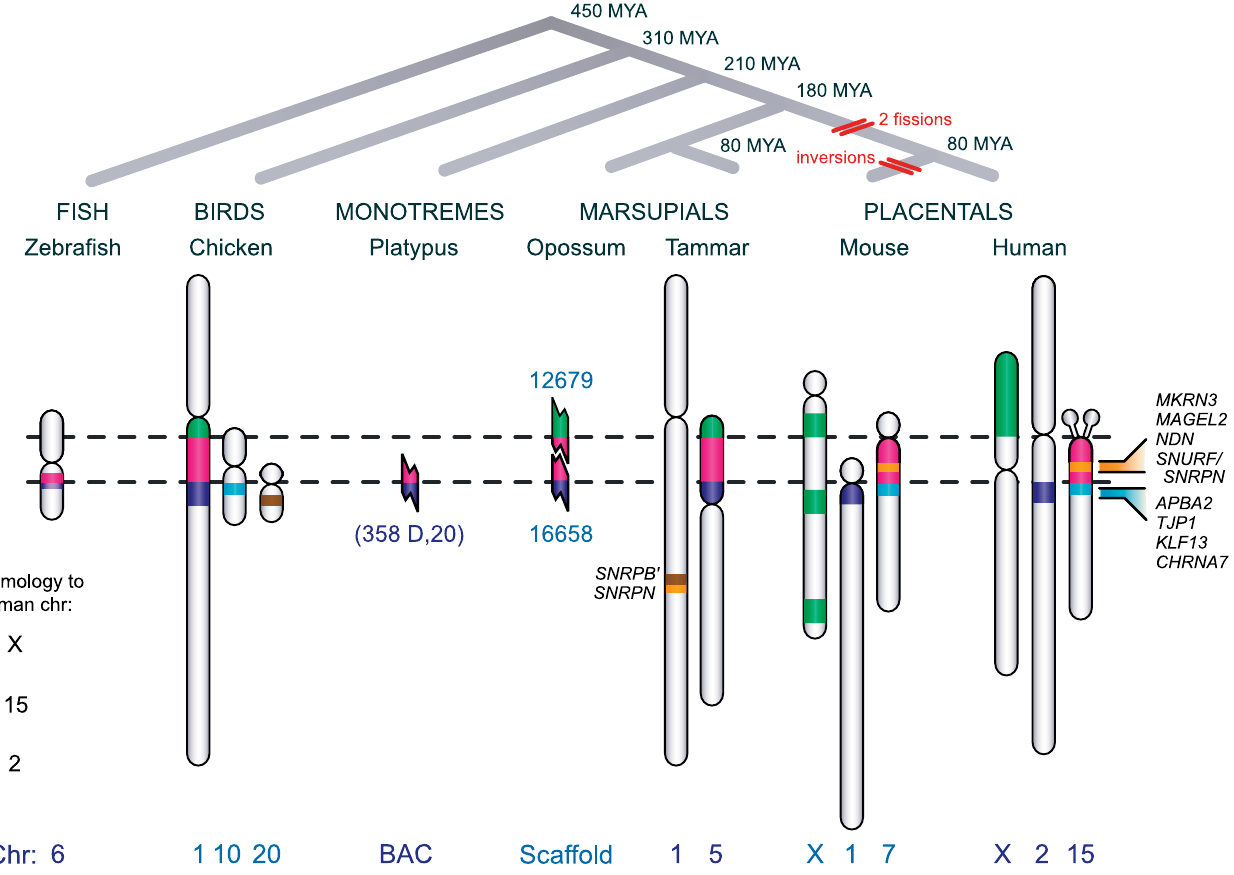
Figure 4. Assembly of the PWS-AS Imprinted Region in Placental Mammals during Vertebrate Evolution Relationships between fish, birds/reptiles, and the three mammal groups are presented as a phylogeny (top). In the ancestral arrangement, shared by marsupials, monotremes, birds, and fish, the block of imprinted human 15q genes (pink) is flanked by human X (green) and human 2 (purple) blocks. These three blocks were separated by at least two fissions and were rearranged next to an unlinked block of genes (on chick Chromosome 10, pale blue) to make up the present regions of human Chromosome 15q (and with two more inversions, of mouse Chromosome 7). SNRPB 9 (brown) is present on a different chromosome in fish, birds, and marsupials, but its duplicate SNRPN (orange) is transposed next to UBE3A in placentals. Other human 15q genes absent from non-placental vertebrates (orange) were independently added to the imprinted region in the placental lineage. DOI: